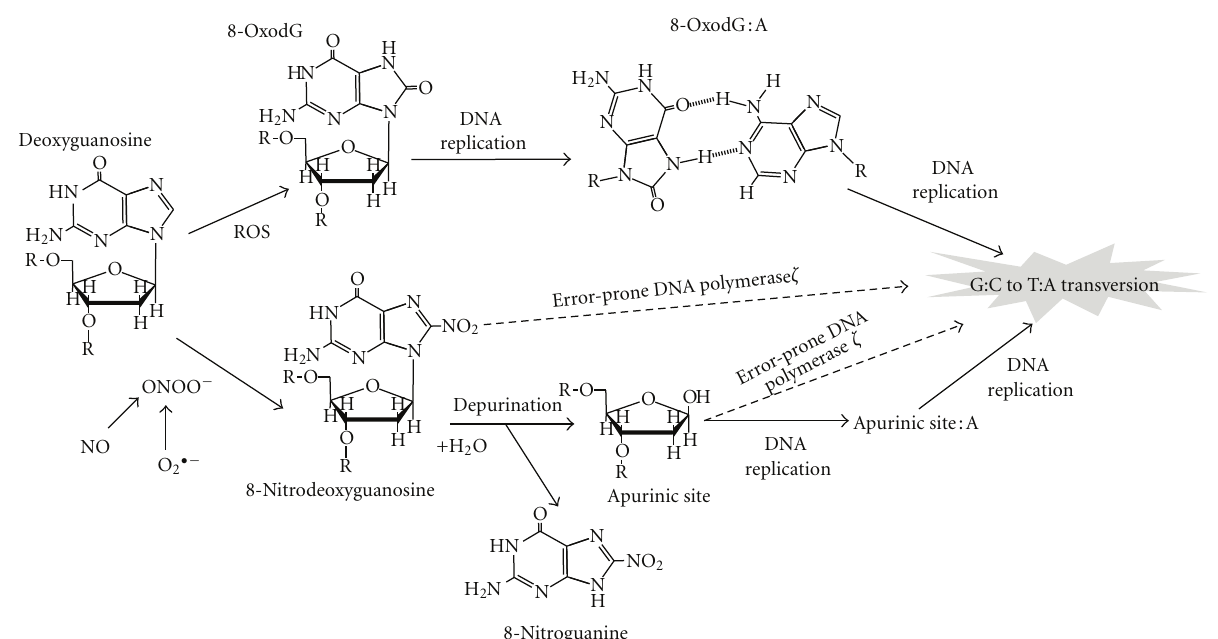
Figure 1: Proposed mechanism of point mutation induced by 8-nitroguanine and 8-oxodG through induction of the G:C → T:A transversion. Table 1: Nitrative and oxidative DNA damage in inflammation-induced carcinogenesis. Etiologic agent/pathologic